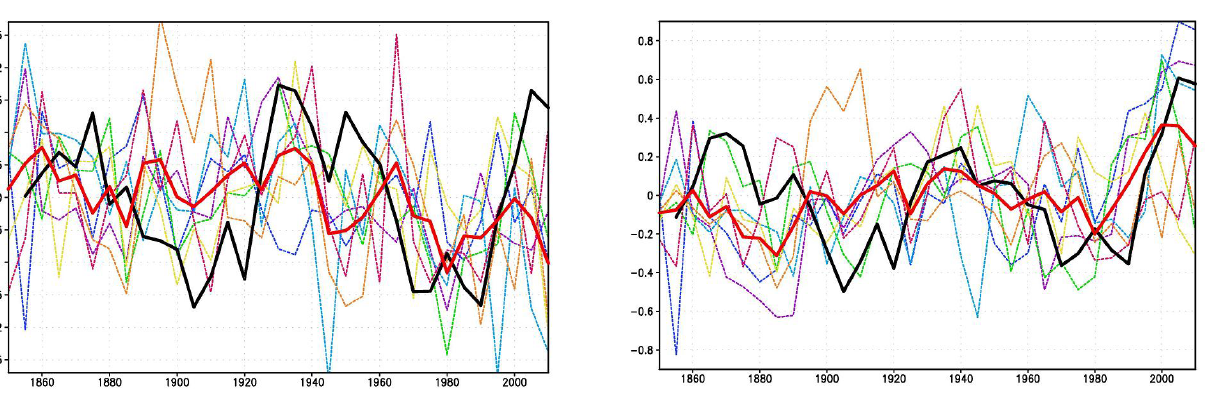
Figure 5. The 5-year mean SST anomaly (K) with respect to 1850– 1899 in the North Atlantic (45–65 ◦ N) for ERSSTv4 data (thick solid black); model mean (thick solid red). Dashed thin lines rep- resent data from individual model runs. Colors correspond to indi- vidual runs as in Fig. 1.